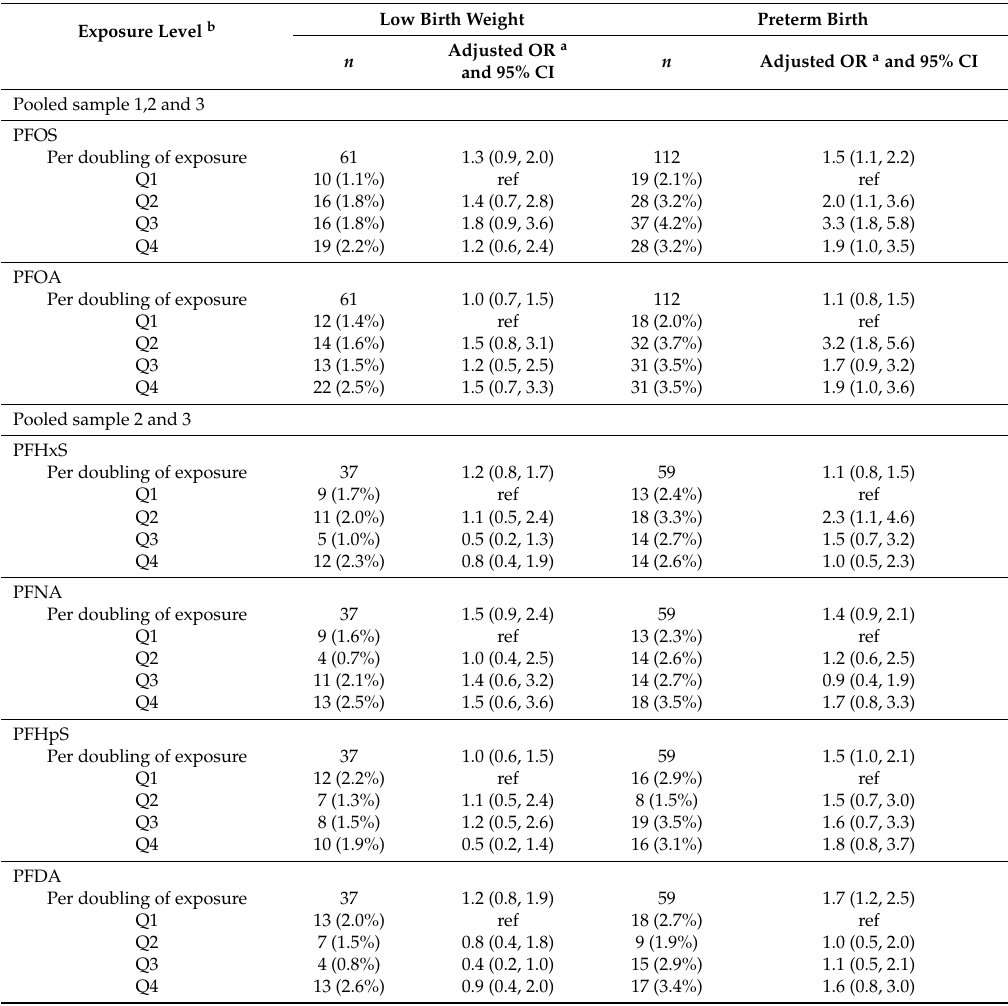
Table 3. Adjusted Odds Ratios (OR) and 95% confidence intervals (CI) for low birth weight and preterm birth according to prenatal PFASs exposure